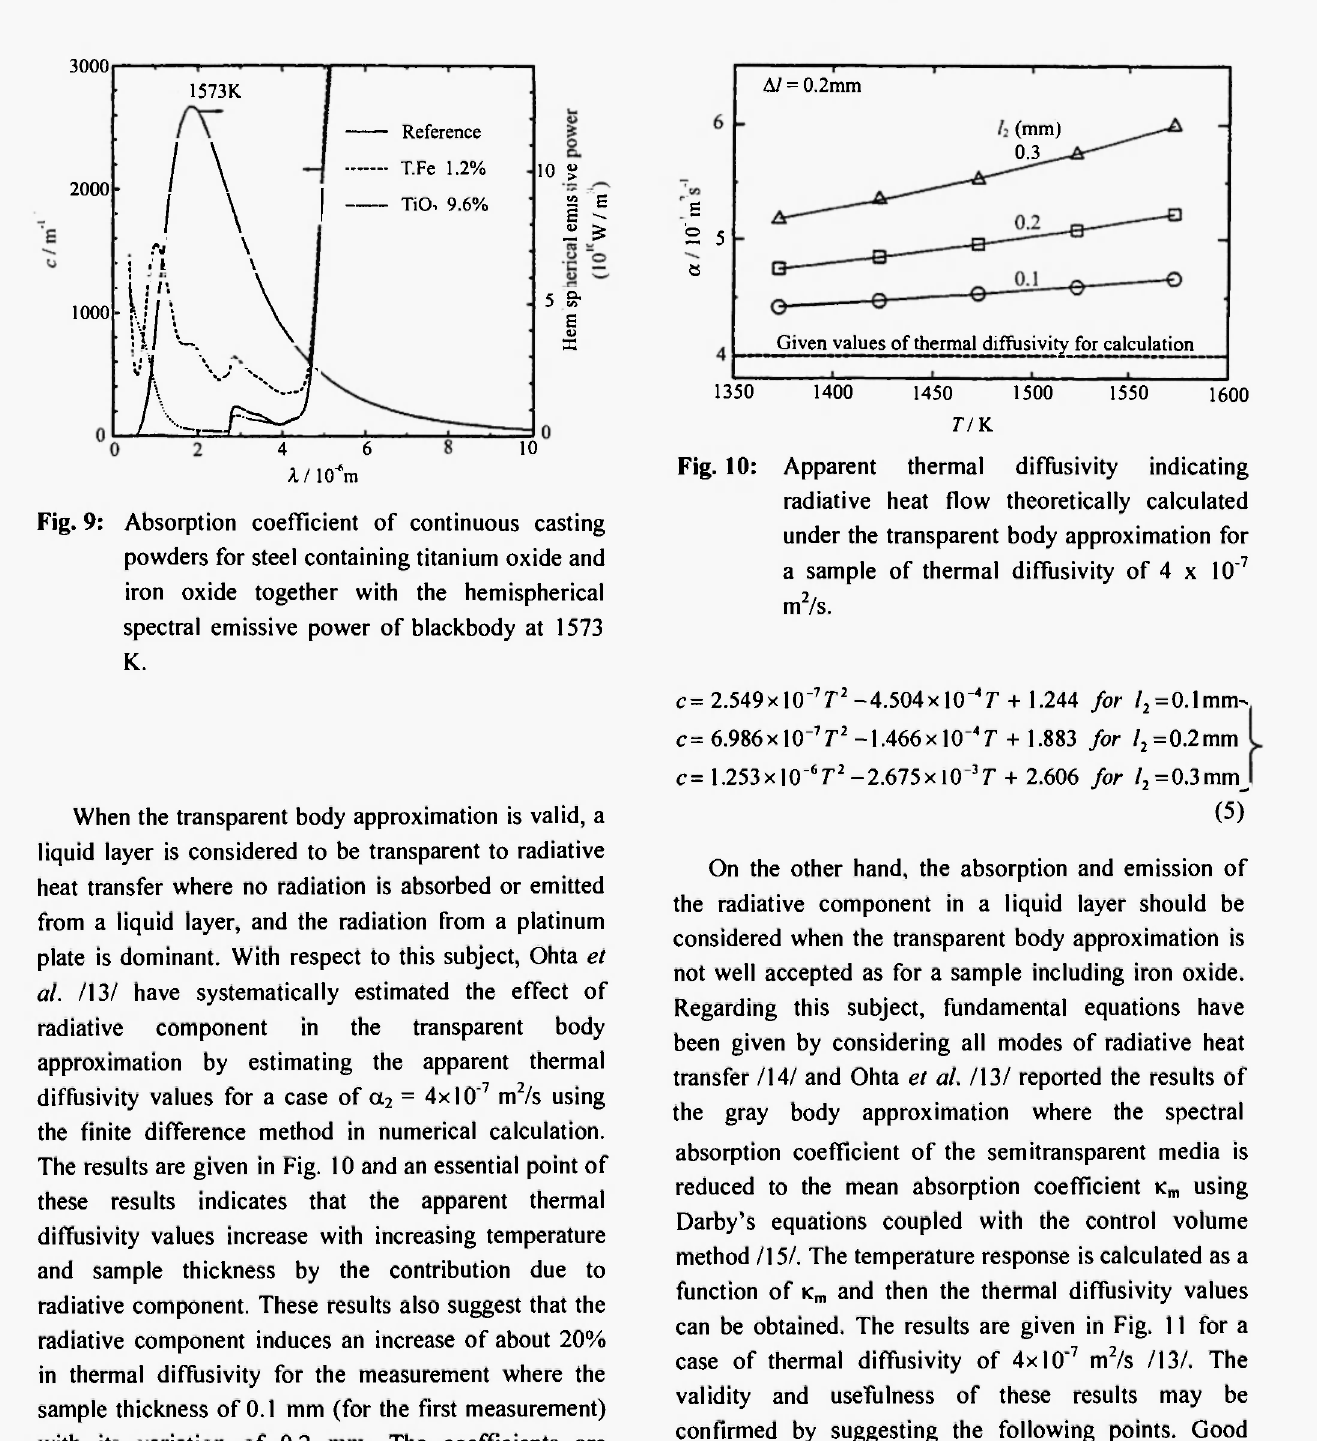
Fig. 9: Absorption coefficient of continuous casting powders for steel containing titanium oxide and iron oxide together with the hemispherical spectral emissive power of blackbody at 1573